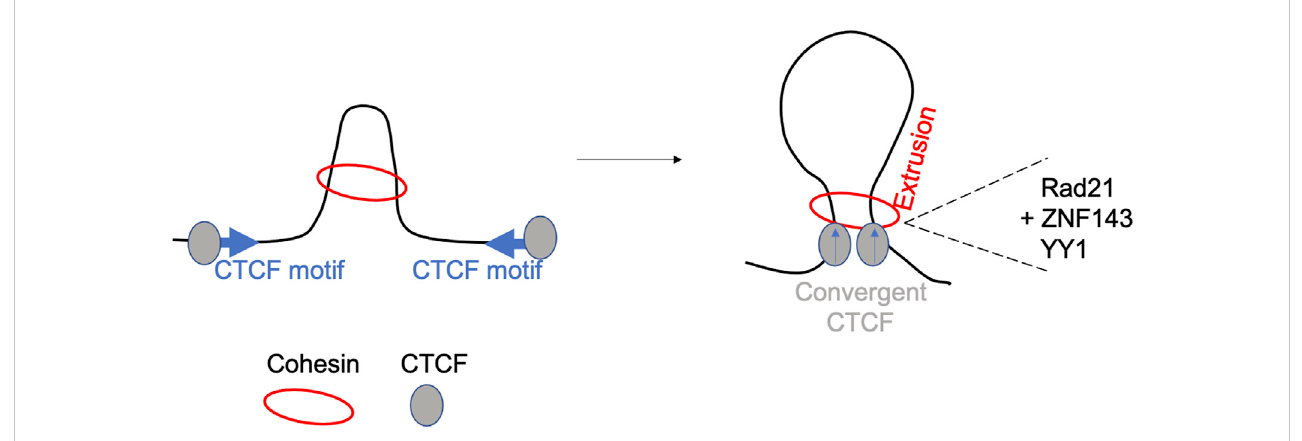
FIGURE 2 The loop-extrusion model.The model shows the generation of long-range cis-interactions, following extrusion by cohesin, CTCF cognate sitesbinding and involvement of other accessory proteins including YY1, RAD21 and ZNF143 (Hansen et al.,